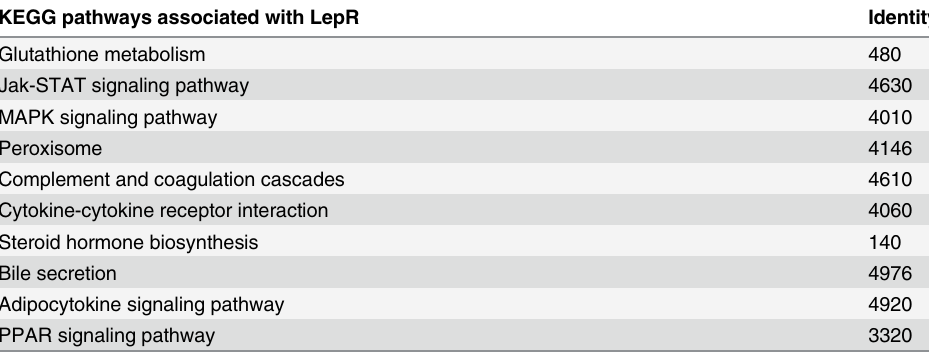
Table 3. Pathways involved in LepR gene site mutation of Y123F mice.